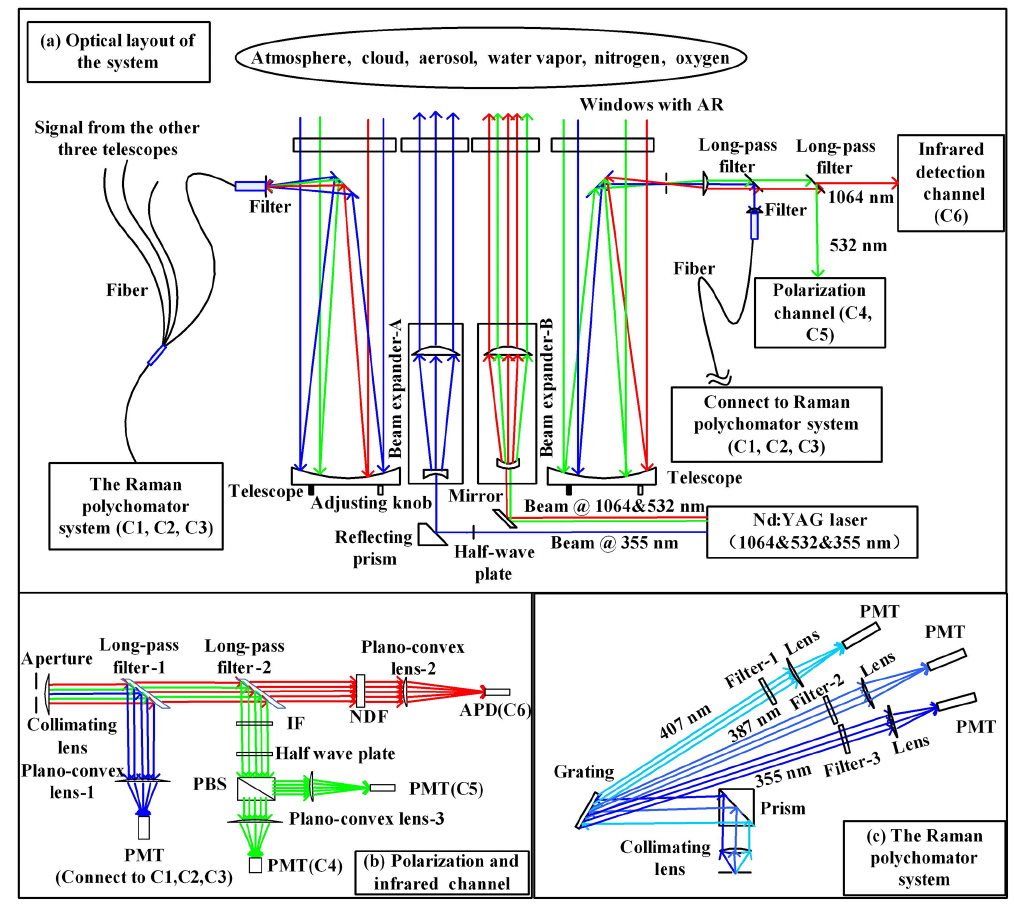
Figure 1. Schematic diagram and photos of